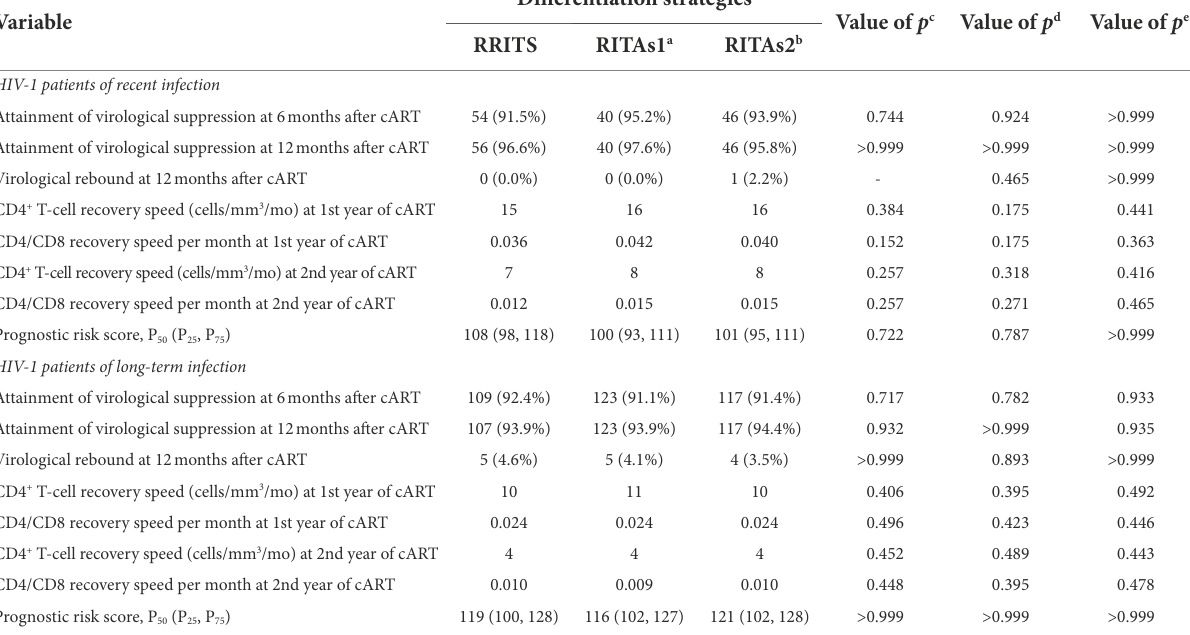
TABLE 2 Analysis of virological response, immune reconstitution and prognostic risk score in 200 cART-treated HIV-1 patients.